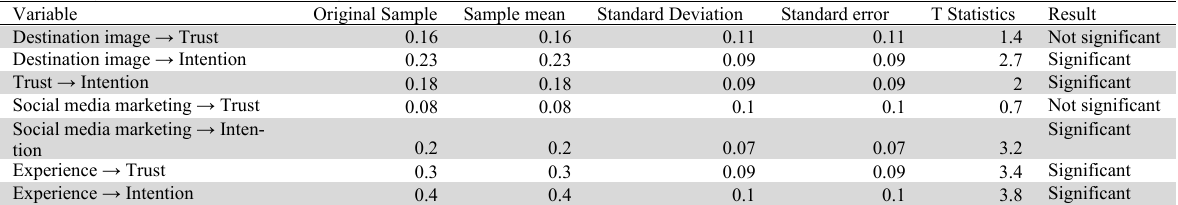
Path Analysis and Statistical